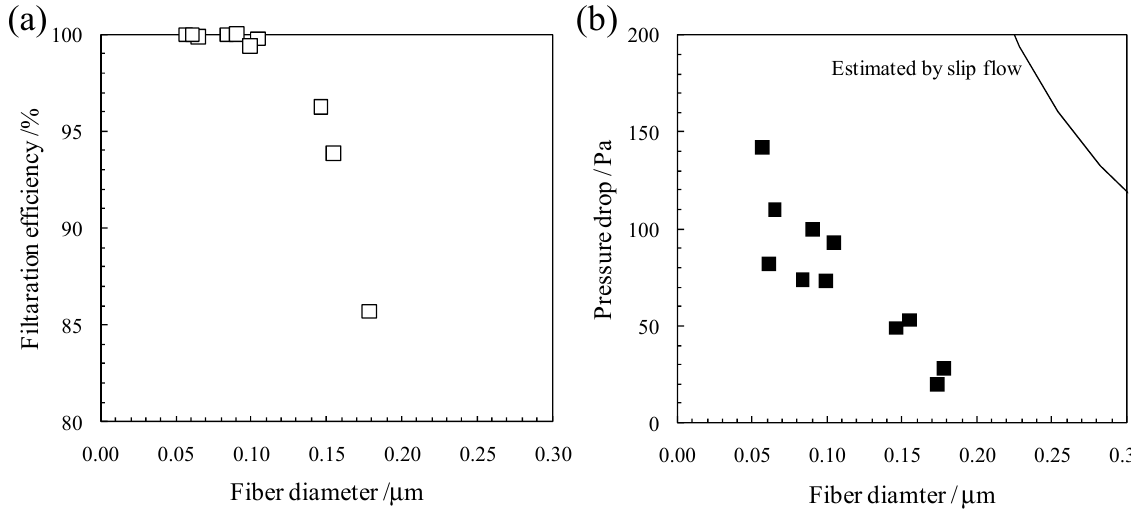
Figure 11. Effect of fiber diameter on ( a ) filtration efficiency and ( b ) pressure drop of the electrospun PAN NFMs. Basis weights of all the samples were fixed at 0.3 g/m 2 . All measurements were performed using particles with a diameter of 0.3 µm under a face velocity of 5.3 cm/s. The filtration efficiency and pressure drop of the glass fibrous nonwoven substrate are 11% and 5 Pa, respectively. Therefore, the contribution of the substrate to the filter performance is negligible.